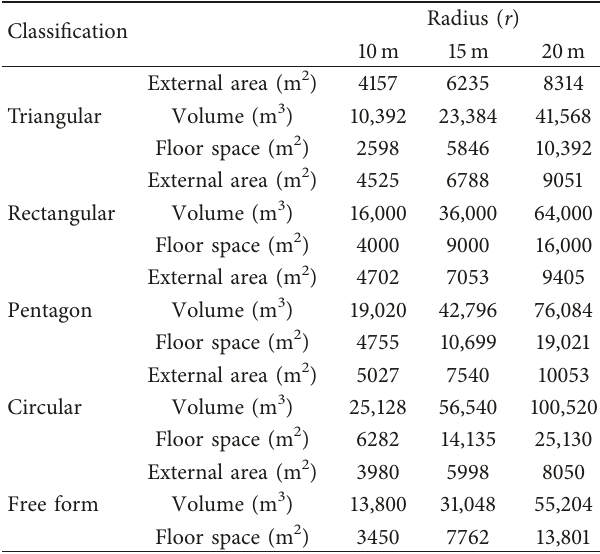
Table 4: Scale arrangements depending on forms of